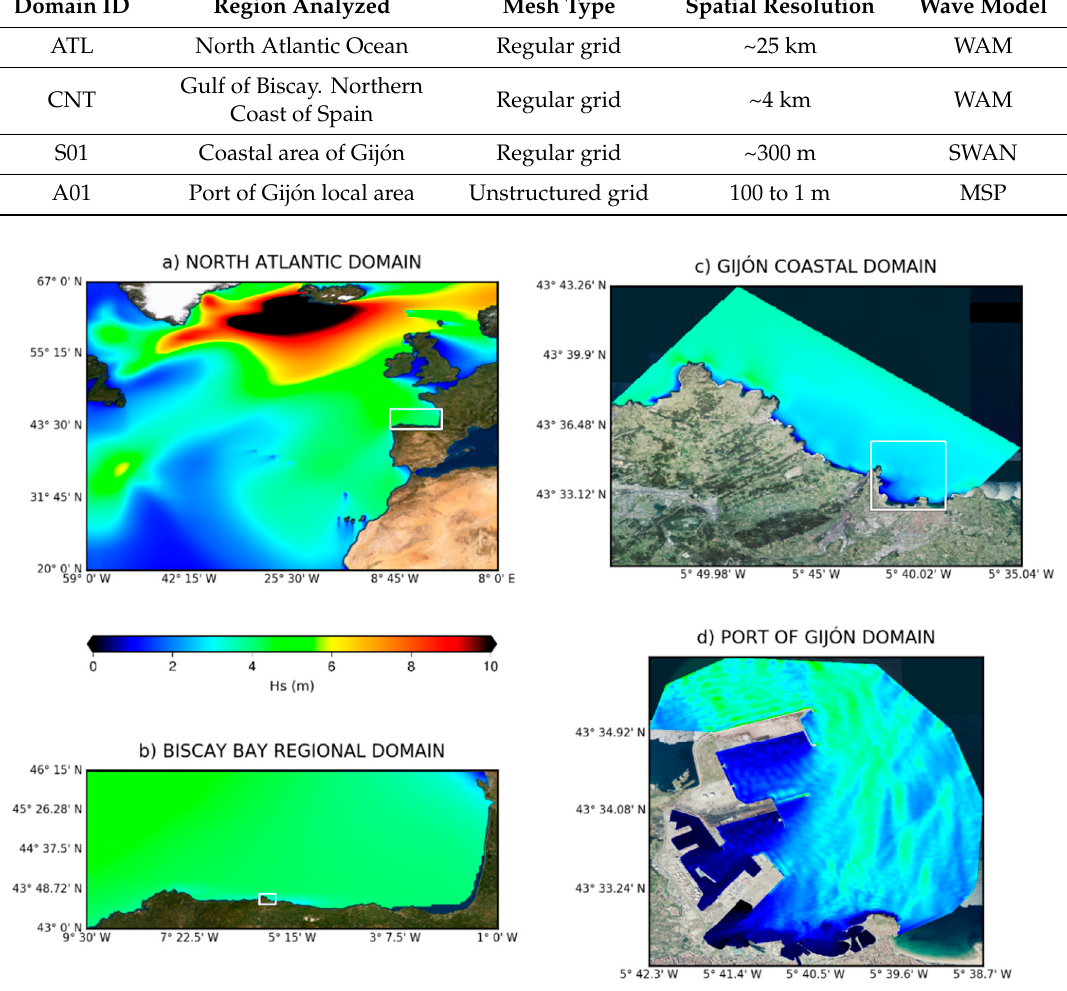
Figure 2. Wave model downscaling approach. White rectangles indicate nested domains; ( a ) large domain covering the North Atlantic; ( b ) Regional domain covering the Biscay Bay; ( c ) Coastal domain covering the near-shore area of Gijón; ( d ) Local domain covering the Port of Gijón.